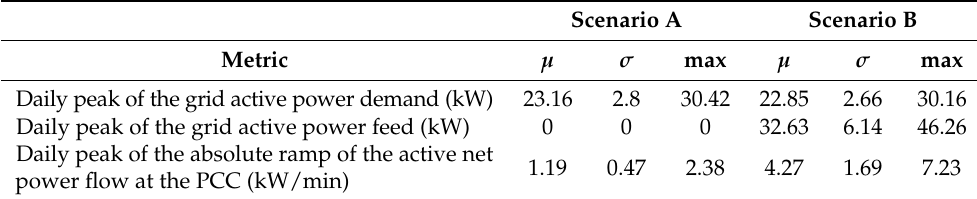
Table 8. Metrics of the active net power flow profile at the PCC with the main grid for Scenario A and B during May 2020. µ : average value, σ : standard deviation, max: maximum